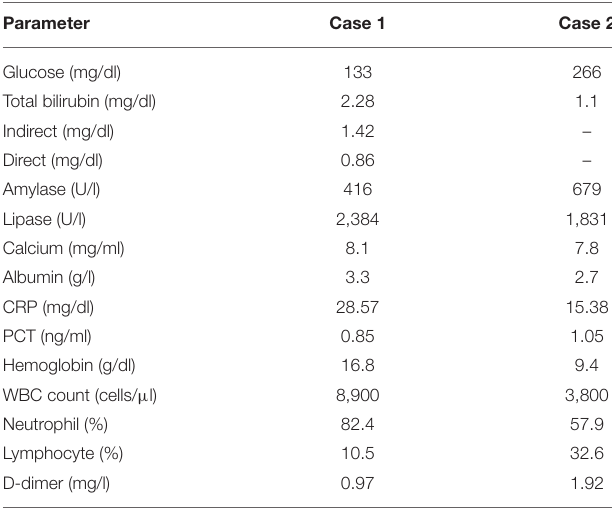
TABLE 1 | Laboratory findings of two patients with COVID-19 related acute